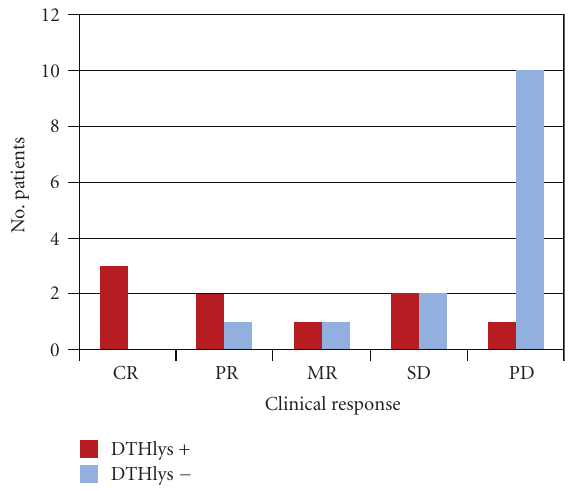
Figure 3: Subdivision of clinical response to DC vaccination on the basis of DTH positivity to lysate (ATL) for the 24 patients